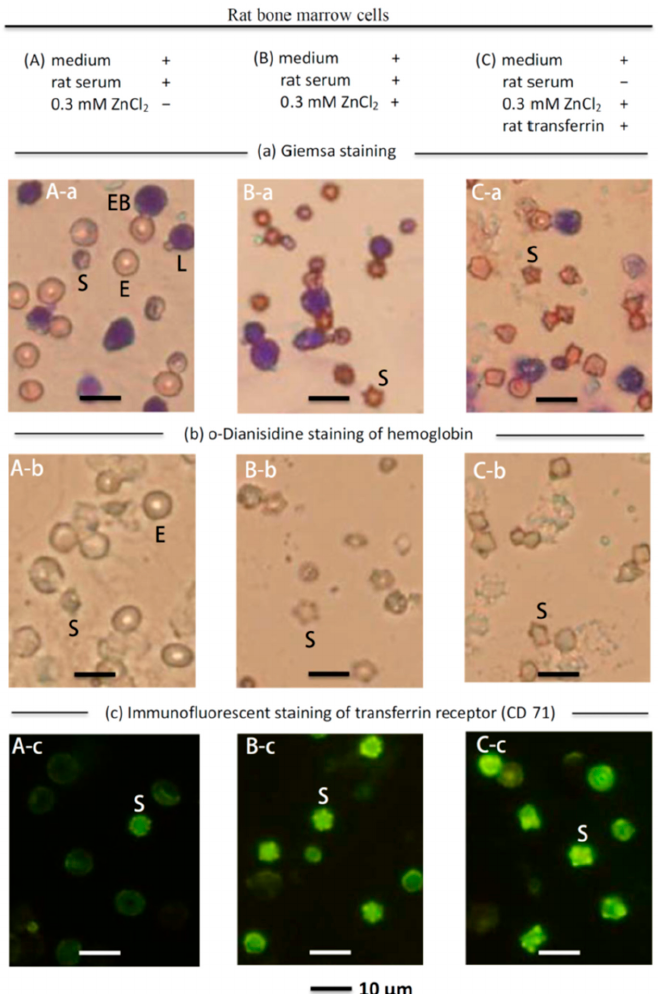
Figure 4. Microscopic observation of cultured rat bone marrow cells with ZnCl 2 supplementation. ( A-a ) Giemsa staining of the rat bone marrow cells (with medium and rat serum) without supplementation of ZnCl 2 suspension-cultured for one day. The major cells were mature erythrocytes with a median cell diameter of 7.4 µ m (E), lymphocytes with a median cell diameter of 7.3 µ m (L), erythroblasts (EB), and smaller ~5 µ m cells (S); ( A-b ) o-Dianisidine staining (to stain erythroid cells) indicated that mature erythrocytes (E) and the ~5- µ m cells (S) were stained; ( A-c ) In CD-71 immunofluorescent staining, only the ~5 µ m cells (S) were stained; ( B-a ) Giemsa staining of the rat bone marrow cells (with medium and rat serum) supplemented with ZnCl 2 and suspension-cultured for one day indicated that most of the original mature erythrocytes (E) disappeared but many ~5 µ m cells (S) appeared, and the lymphocytes (L) remained unchanged; ( B-b ) o-Dianisidine staining indicated that the ~5 µ m cells (S) appeared multilobular and stained positively for hemoglobin; ( B-c ) The ~5 µ m cells (S) showed strong immunofluorescence when stained with the CD-71 antibody; (C-a) Giemsa staining of the rat bone marrow cells in serum-free medium supplemented with ZnCl 2 and rat transferrin suspension-cultured for one day. The cell pattern in ( C-a ) was similar to that of ( B-a ), i.e., many ~5 µ m cells (S) appeared, and most of the original mature erythrocytes (E) disappeared. ( C-b ) o-Dianisidine staining indicated that the ~5 µ m cells (S) appeared to be multilobular and stained positively for hemoglobin like those in ( B-b ); ( C-c ) The ~5 µ m cells (S) showed strong immunofluorescence when stained with a CD-71